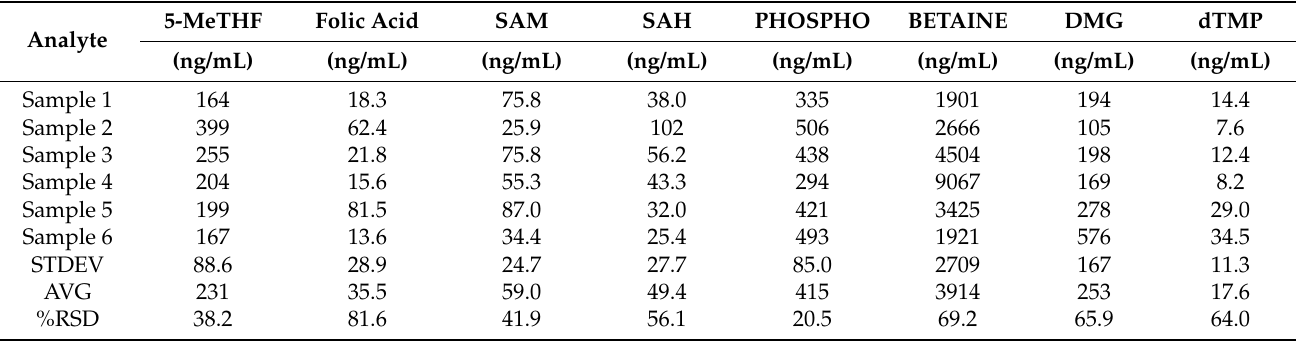
Table 2. Basal levels of analytes in the bloodstream of normal blood donors. The calculation was performed to gain insight into the levels of the analytes as assessed by the developed methodology compared to the corresponding ones determined in the